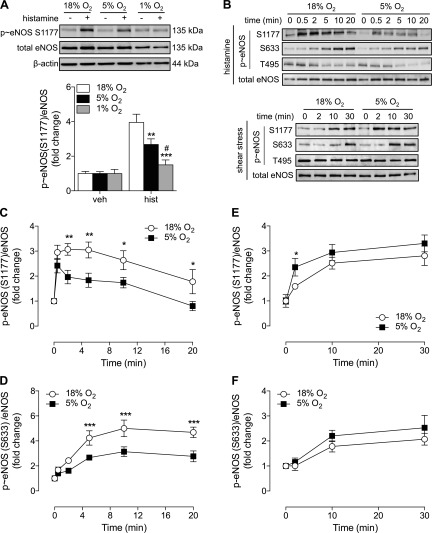
eNOS phosphorylation in HUVECs cultured in various O2 levels. HUVECs were maintained at 18% O2 or cultured in 5 or 1% O2 for at least 5 d. Cells were then stimulated with histamine (10 µM) for 2 min (A) or 0.5–20 min (B–D), or shear stress for 0–30 min (B, E, F), and phosphorylation of eNOS at S1177 (A–C, E) and S633 (B, D, F) (human sequence) assessed by immunoblot analysis relative to total eNOS, a β-actin loading control, or both. Data are expressed as fold change and are means ± sem (n = 4–6 different donors). Treatment with histamine or shear stress was significant (P < 0.05 vs. respective control) in relevant panels, except at 1% O2 in A. *P < 0.05, **P < 0.01; ***P < 0.001 vs. 18% O2; #P < 0.05 vs. 5% O2.